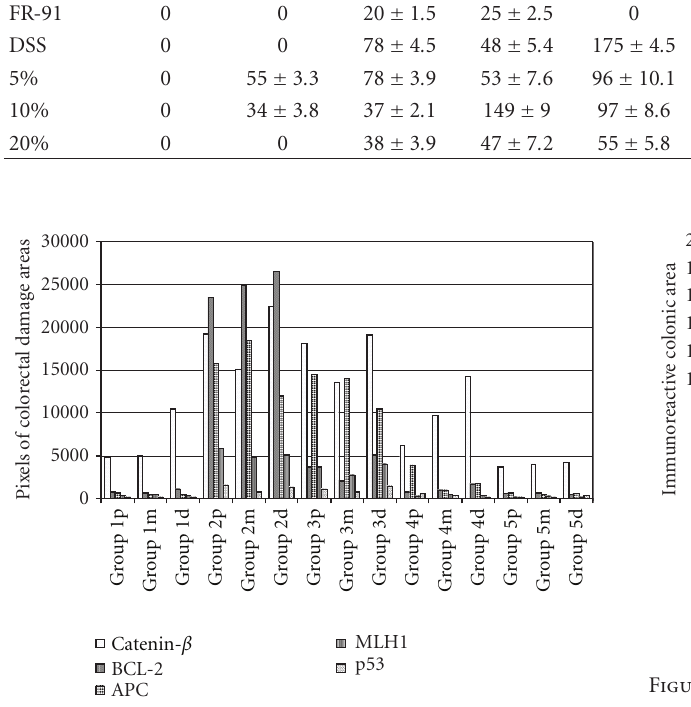
Figure 4: Image analysis of colorectal damaged area observed in the three portions of the colon in each experimental mice group. The quantification in pixels of the immunoreactive area a ff ected was performed by a software analysis of the colorectal sections studied. Group 5 showed a significantly di ff erence ( P < 0 . 05) to the other treatment groups (3 and 4).